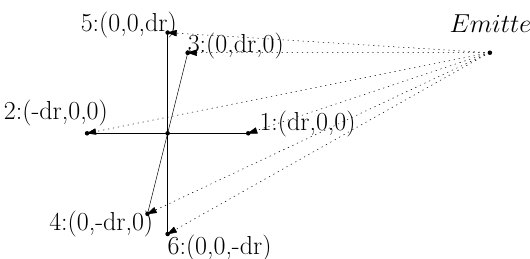
Figure 3. The local coordinates of every intensity sensor positioned on a UUV. The origin of the local coordinates frame is at the UUV’s center. The numbering in front of local coordinates indicates the index of the associated intensity sensor. We can see that every intensity sensor is positioned at equidistant point from the UUV’s center. Here, dr is the relative distance between the UUV’s center and any other